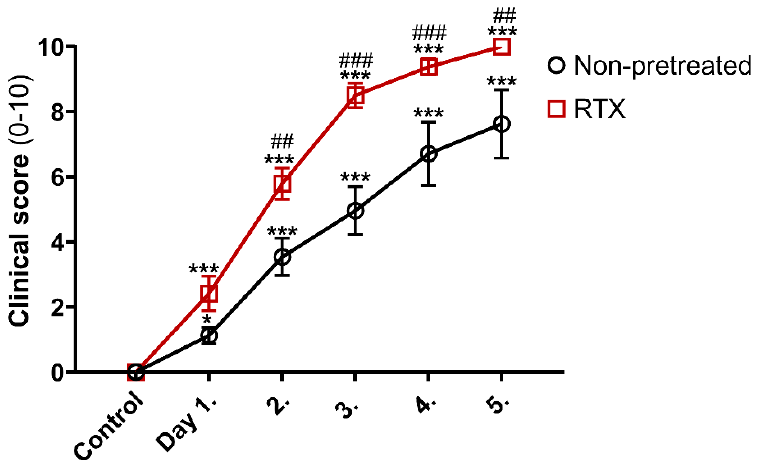
Figure 2. Clinical arthritis severity scores of non-desensitized and RTX-desensitized (sensory de- functionalized) mice. Data points represent mean values ± SEM of n = 6/group, both hindlimbs; two-way ANOVA and Fishers LSD test, * p < 0.05, *** p < 0.001 vs. pre-treatment self-control values, ## p < 0.01, ### p < 0.001 vs. non-pretreated group.